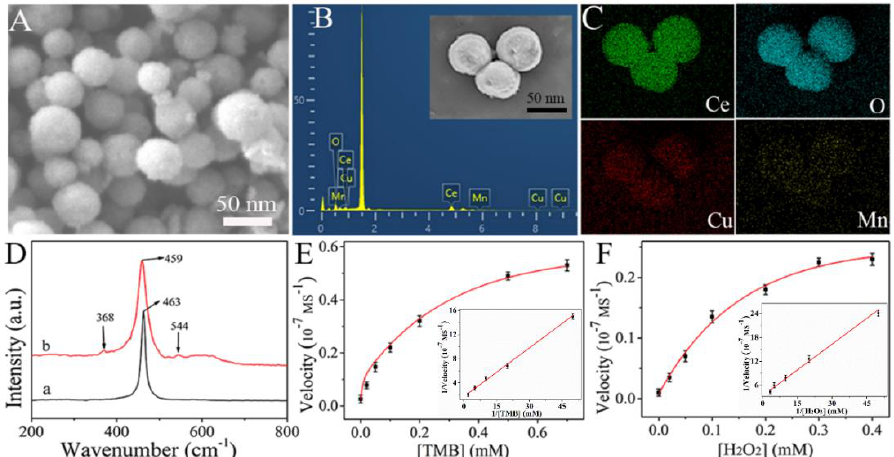
Figure 4. ( A ) SEM image, ( B ) EDS, and ( C ) mapping of CuMn@CeO 2 . ( D ) Raman spectra of (a) CeO 2 and (b) CuMn@CeO 2 . Michaelis–Menten curves at ( E ) fixed concentration of H 2 O 2 (2 mM) and various concentrations of TMB (0–0.7 mM) and ( F ) fixed concentration of TMB (0.6 mM) and various concentrations of H 2 O 2 (0 − 0.4 mM) (inset: corresponding Lineweaver − Burk